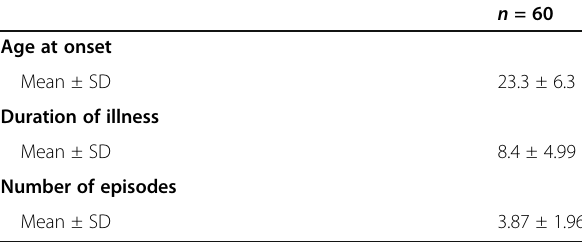
Table 2 Clinical variables of the patients